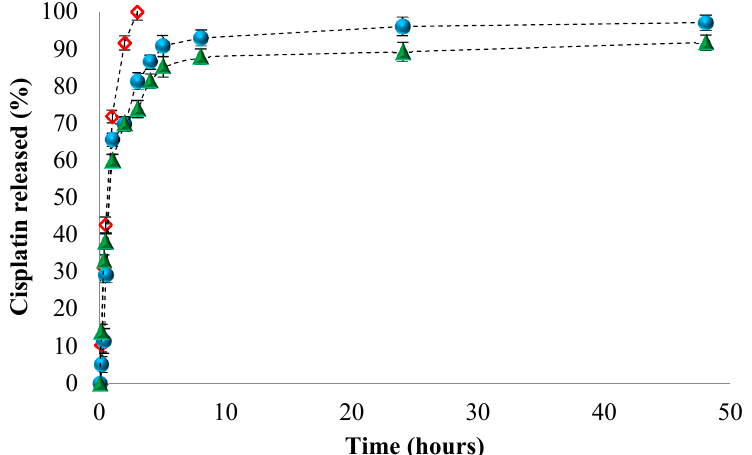
Figure 2. In vitro release kinetics of free (diamonds) and Cis loaded in the PNVP (NPs4) (full circles) and PCL-based (NPs6) (full triangles) NPs in phosphate buffer solution (pH 7.4).